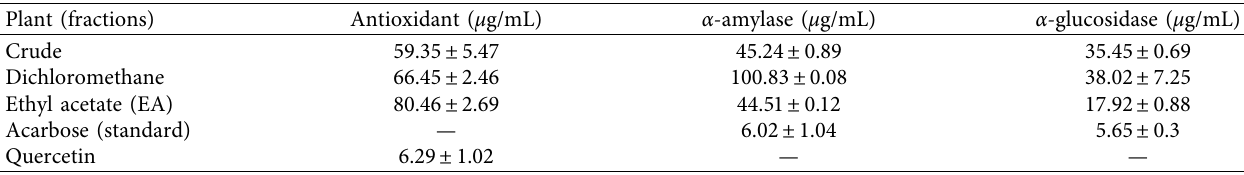
Table 2: IC 50 values of the antioxidant, α -glucosidase, and α -amylase inhibition activity of Erythropalum scandens . Plant (fractions)